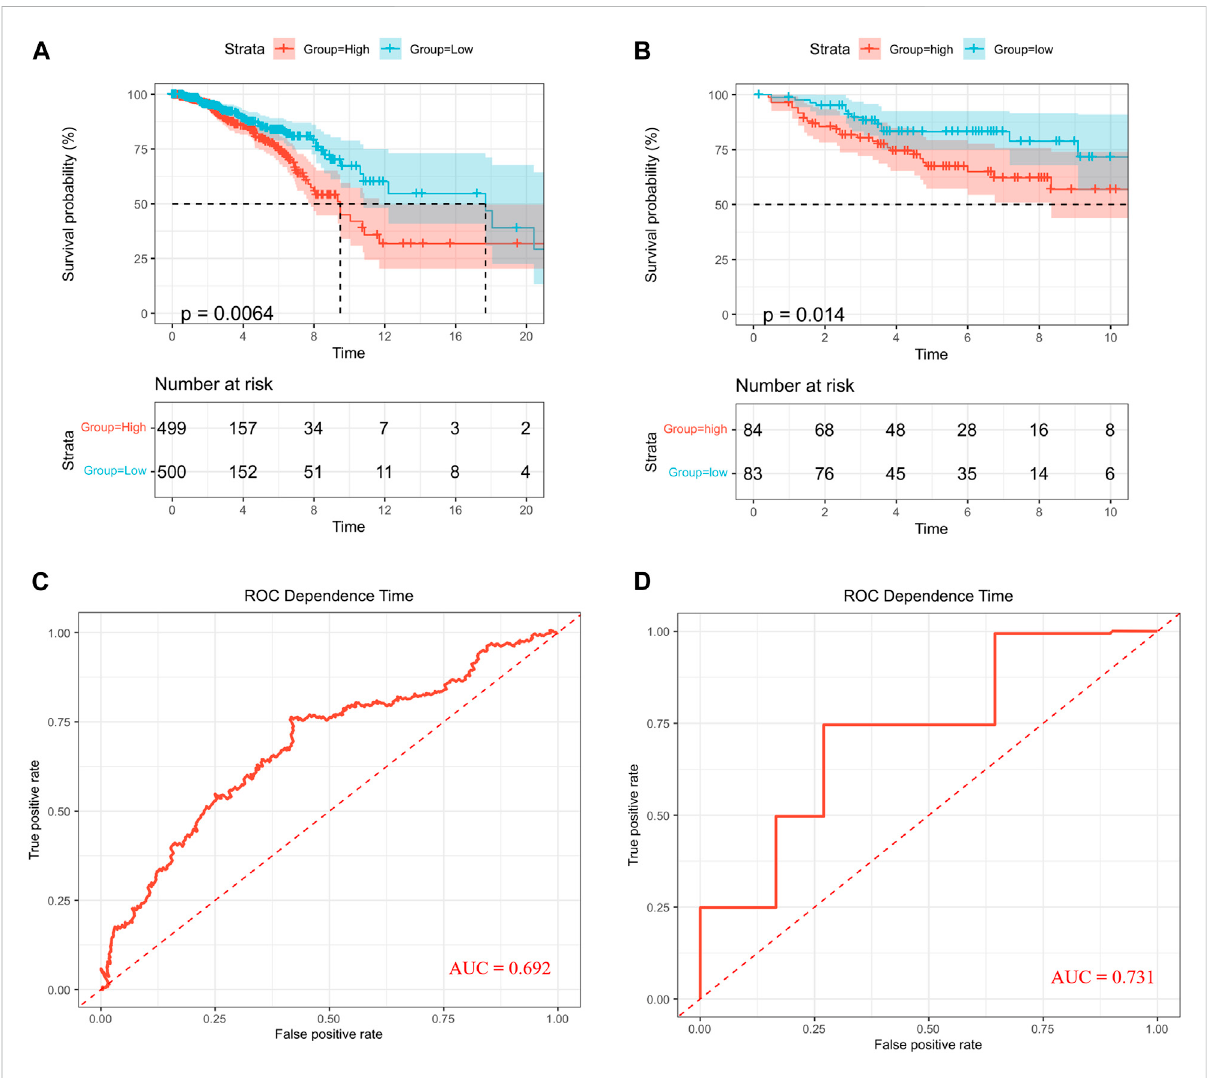
FIGURE 3 Survival analysis. Kaplan – Meier curves in TCGA (A) and GEO (B) . ROC curves in TCGA (C) and GEO (D)